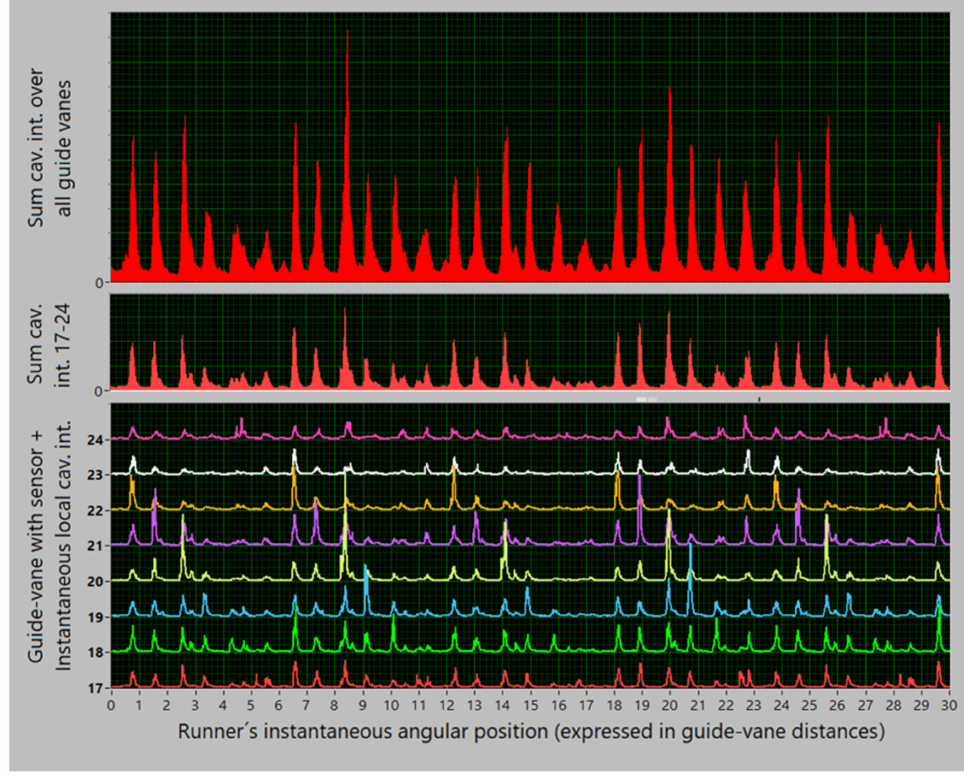
Figure 3. Front panel of the multidimensional data acquisition processor. The simplest description of cavitation comes out online after half an hour of measurement on the prototype. More compli- cated descriptions require days or weeks of recorded data analysis by a trained user.